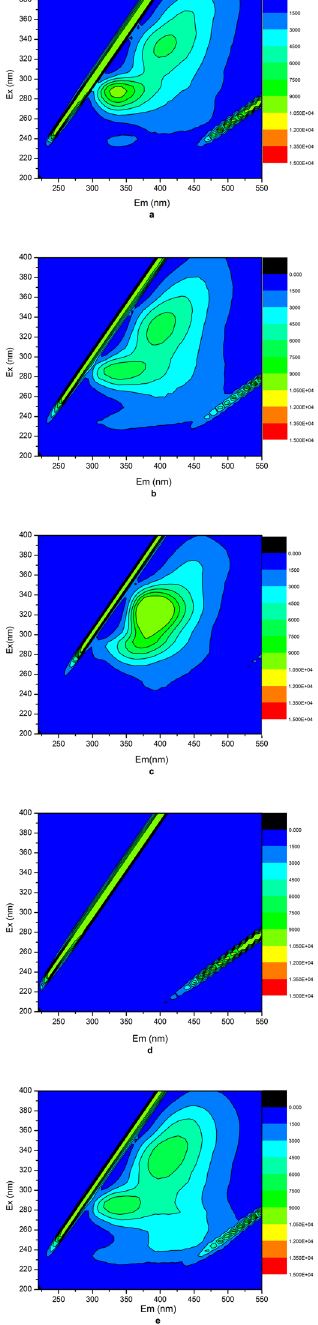
Figure 3. SEPS 3D-EEM fluorescence spectra under sludge